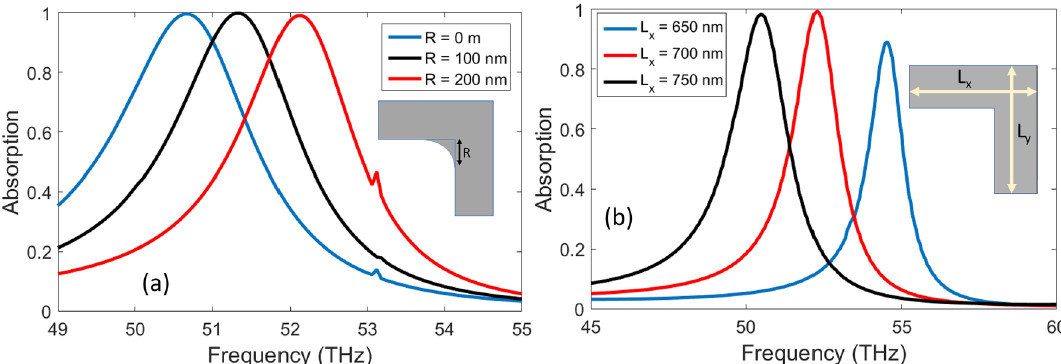
Figure 6. (a) The absorption spectrum due to variation in fillet radius around the right-angle edge of L-shaped structure. (b) The absorption spectrum due to variation in length of L-shaped arms. The graphical description about length of length shaped arms is already provided in Fig. 2.